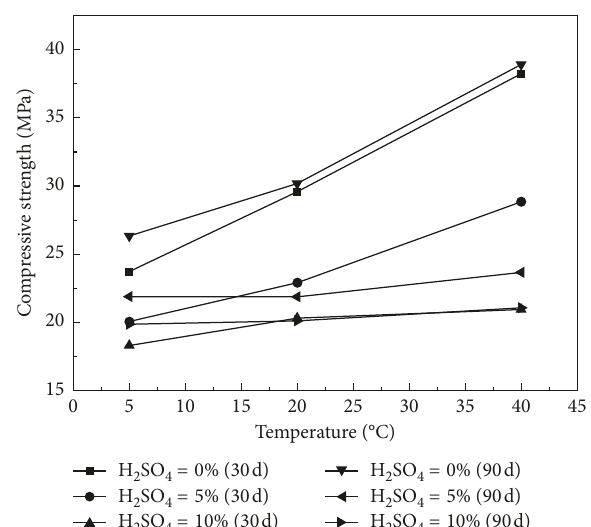
Figure 3: Variation of compressive strength of concrete specimens with temperature.